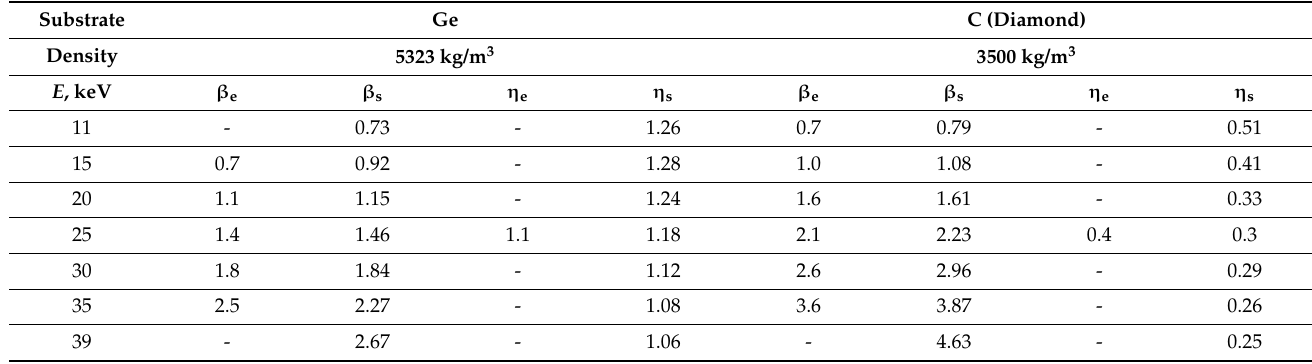
Table 4. Comparison of the parameters of the proximity function obtained in the experiment β e , η e and as a result of calculating β s , η s for different energies of electrons E , Ge substrates and diamond. The PMMA resist (ERP-40) 0.5 µ m